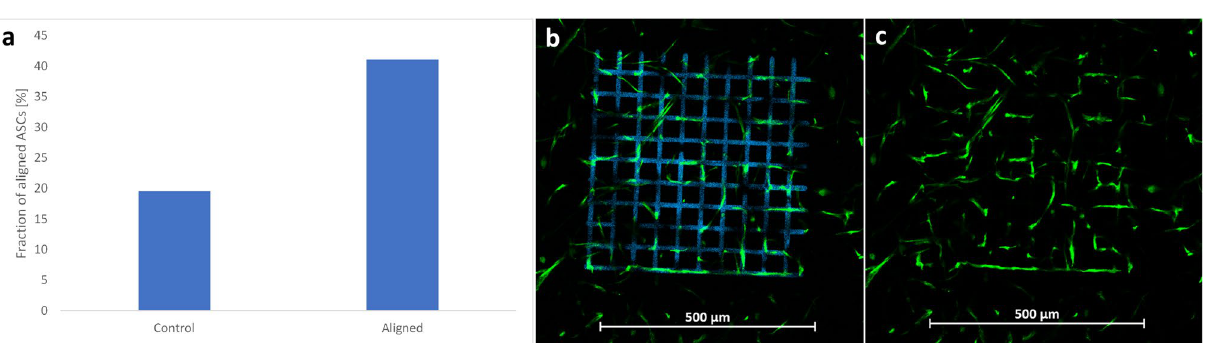
Figure 2. ( a ) Single image quantification of the orientation of hASCs in response to a photografted pattern on day 13. ( b and c ) GFP-hASCs encapsulated at a density of 1000 cells per 1 µL in a gelatin-based hydrogel. Image was taken on day 13 after photografting. In image ( b ) the grafted structure is fluorescing in blue. This signal is suppressed in image ( c ) to highlight the cellular alignment. The scale bars represent 500 Directional migration of hASCs. Co-culture spheroids of hASCs and HUVECs in a 1 to 1 ratio have been encapsulated in gel-MA and the migration has been studied by means of laser scanning microscopy, in an effort to analyze the influence of the hydrogel modifications on the migration direction of cells. A design that ensures a high coverage of the spheroid’s vertical surface and thereby maximizes the ratio between guided and random migration has been created (Fig. 3a). It consists of 24 elongated isosceles trapezoidal- like structures (largest cross section: 100 µm × 30 µm; smallest cross section: 20 µm × 30 µm) arranged in three star-shaped layers. The isosceles trapezoidal-like patterns have been produced at different power settings for each direction (between 125 and 300 mW with a stepwise increase of 25 mW; Fig. 3a), to study the influence of printing power on directional cell migration. A cuboid has been grafted to denote the structure with the lowest power and to subsequently indicate the direction of increasing laser power. In Fig. 3a, the grafted star-shaped pattern, fluorescing in blue, is wrapped around the co-culture spheroid located at the center of the image. The images have been taken on day 3 after grafting and depict a maximum intensity projection (MIP) of a z-stack taken along the vertical diameter of the spheroid. An image showcasing the 3D nature of the pattern, photografted around a spheroid, is displayed in Figure S3. Looking solely at the green-fluorescent signal in Fig. 3c, the grafted star-shaped structure becomes clearly visible, confirming that the hASCs have migrated into the pre-defined regions. Areas where the photografted structure is in contact with other spheroids on the same plane exhibit a higher cell density. This effect is especially pronounced in the top